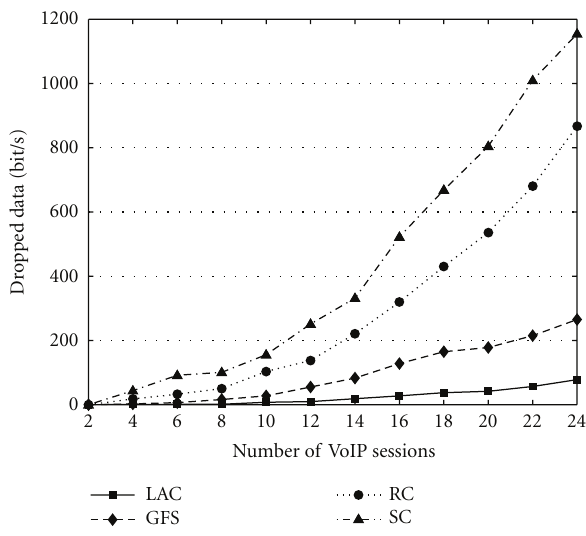
Figure 6: Average dropped data with VoIP tra ffi c.